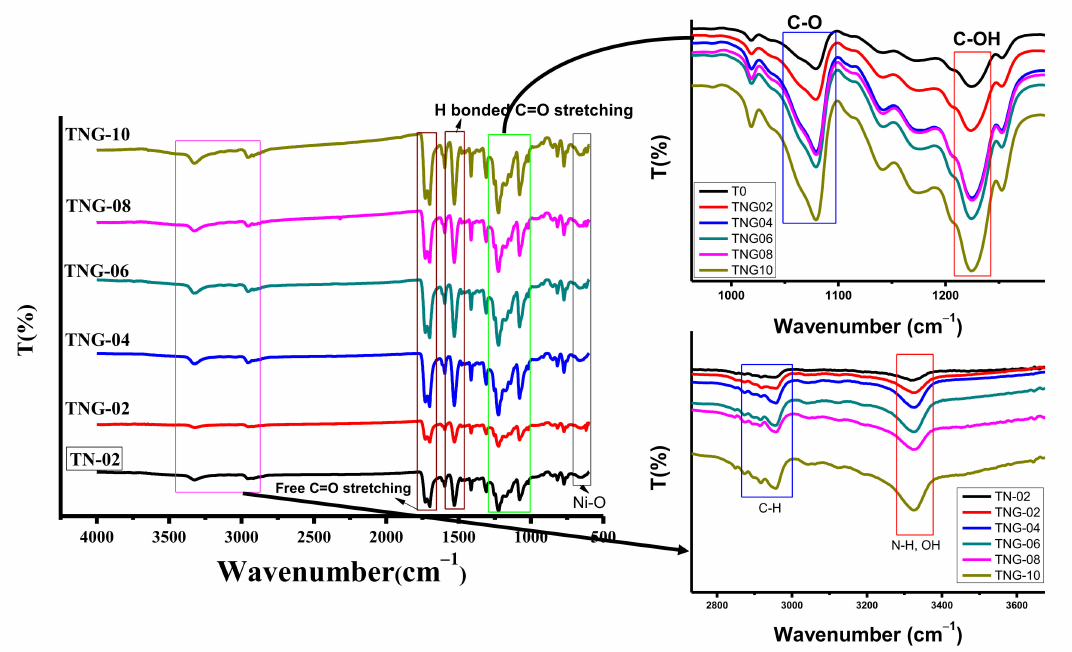
Figure 1. FTIR analysis of NiO/TPU and various ratio of NiO/NH 2 -GO based TPU